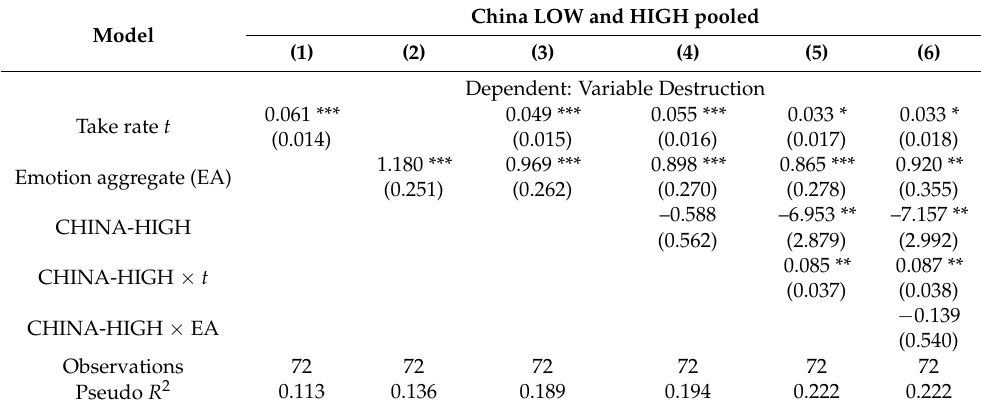
Table 2. CHINA LOW and HIGH: Impact of take rate and emotions on destruction (pooled